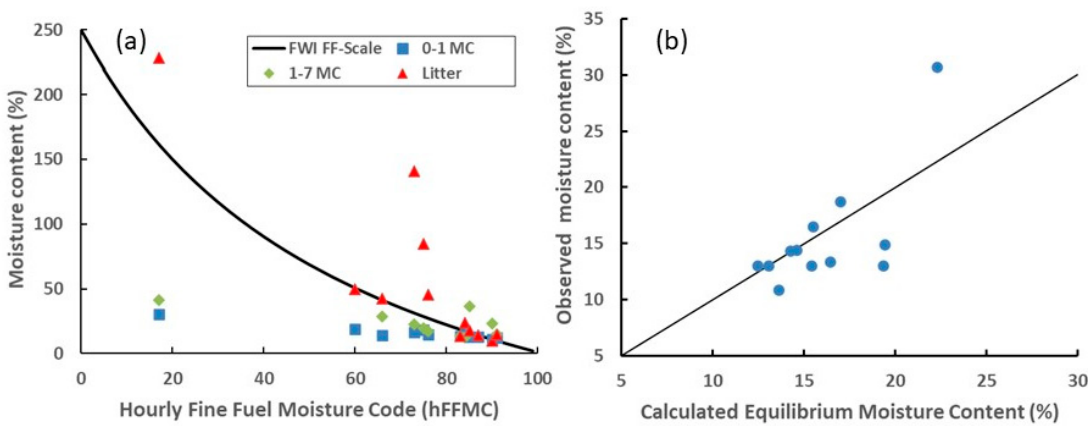
Figure 5. ( a ) Observed moisture content plotted against calculated hourly Fine Fuel Moisture Code (hFFMC) value for sample time for each fine fuel class sampled (overall n = 33) within in Nova Scotia Special fuel type (the line represented the standard FWI System ‘FF-scale’ model used for transforming fine fuel moisture content to its FWI System ‘Code’ value [8]). ( b ) the relation between litter Equilibrium Moisture Content (%) ([10]) and observed elevated dead moisture in the 0–1 cm diameter class (r = 0.7; p = 0.01); the line of identity (y = x) is shown.